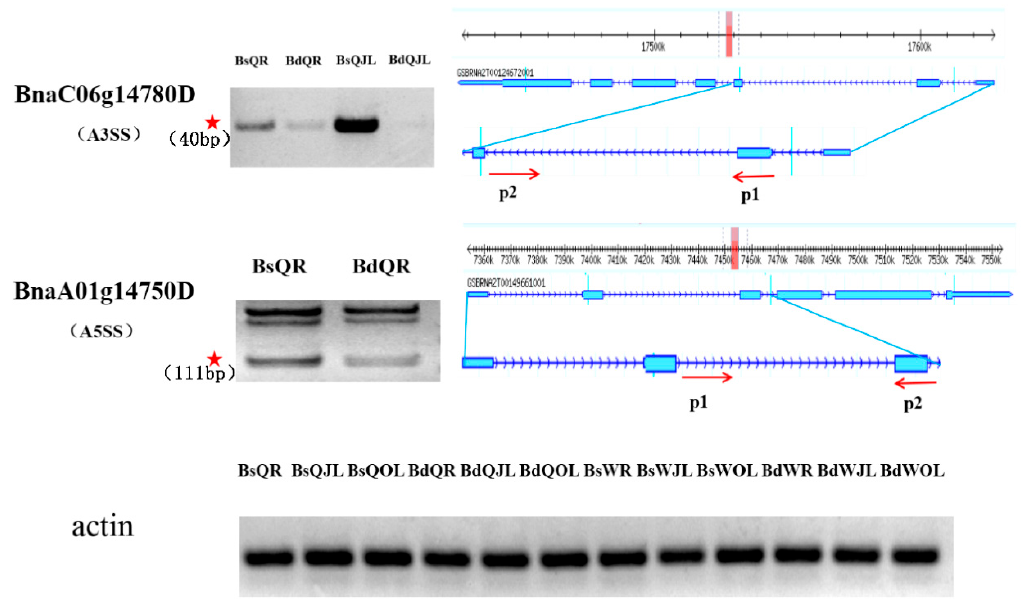
Figure 12. Validation of differential alternative splicing factors in the root and juvenile leaves of B. napus cultivars Qingyou10 (QY10) and Westar10 (W10) under boron deficient conditions. The band with the red asterisk show the fragment generated by the alternative splicing of the gene, which was determined according to the size of the insert fragment. The forward and reverse primers, P1 and P2, were used to amplify the insert fragment and side exon. Bs, boron sufficient condition; Bd, boron deficient condition; QR, root of QY10; QOL, old leaves of QY10; QJL, juvenile leaves of QY10; WR, root of W10; WOL, old leaves of W10; WJL, juvenile leaves of W10. A3SS, alternative 3 ′ splicing site; A5SS, alternative 5 ′ splicing site.